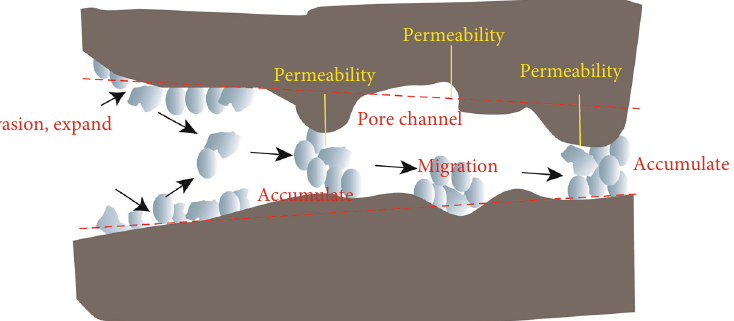
Figure 10: In fl uence of particle migration on